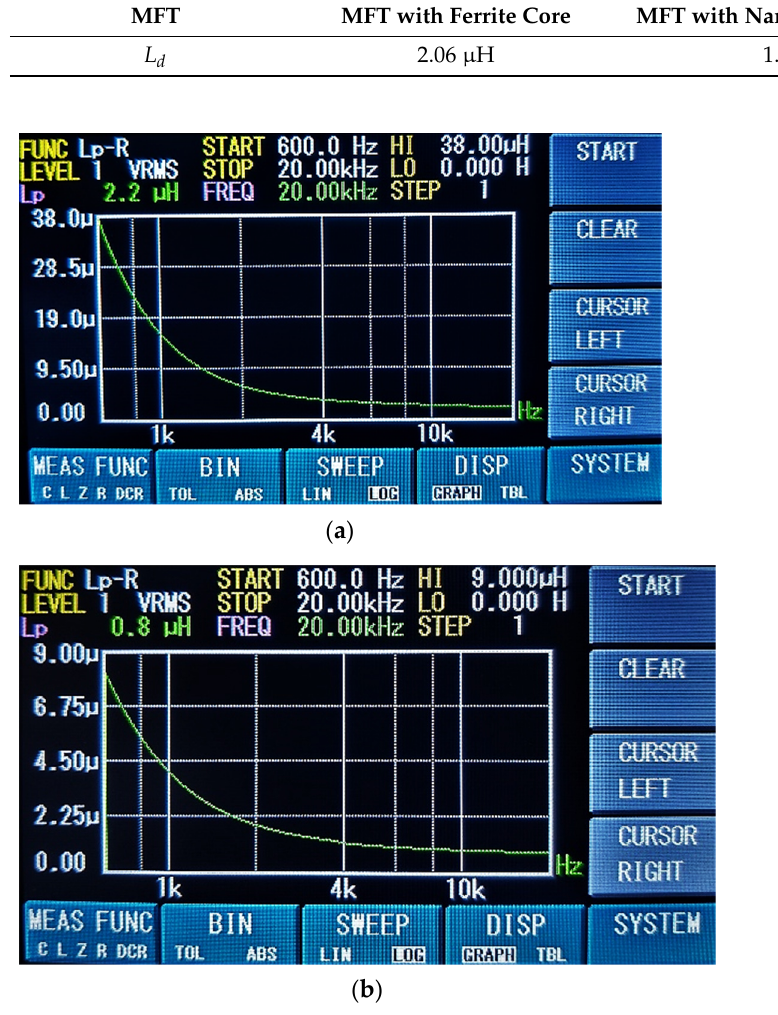
Figure 5. The 0.6–20 kHz L d curves: ( a ) ferrite, ( b ) nanocrystalline